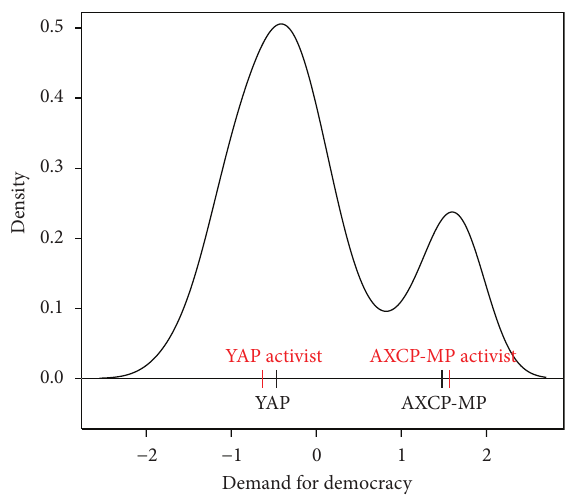
Figure 11: Party positions and voters distribution in the 2007 Russian election. Figure 12: Voter distribution and activist positions in the 2010 Azerbaijani